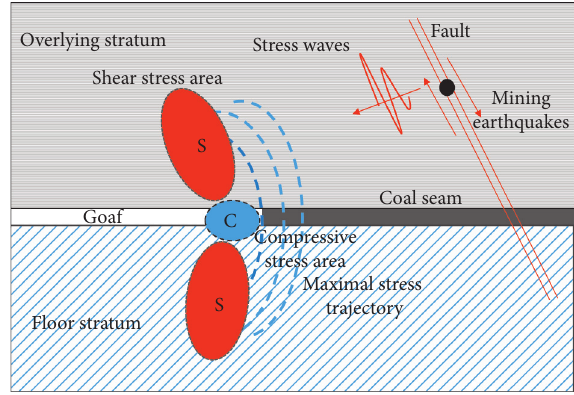
Figure 14: Schematic diagram of mining stress